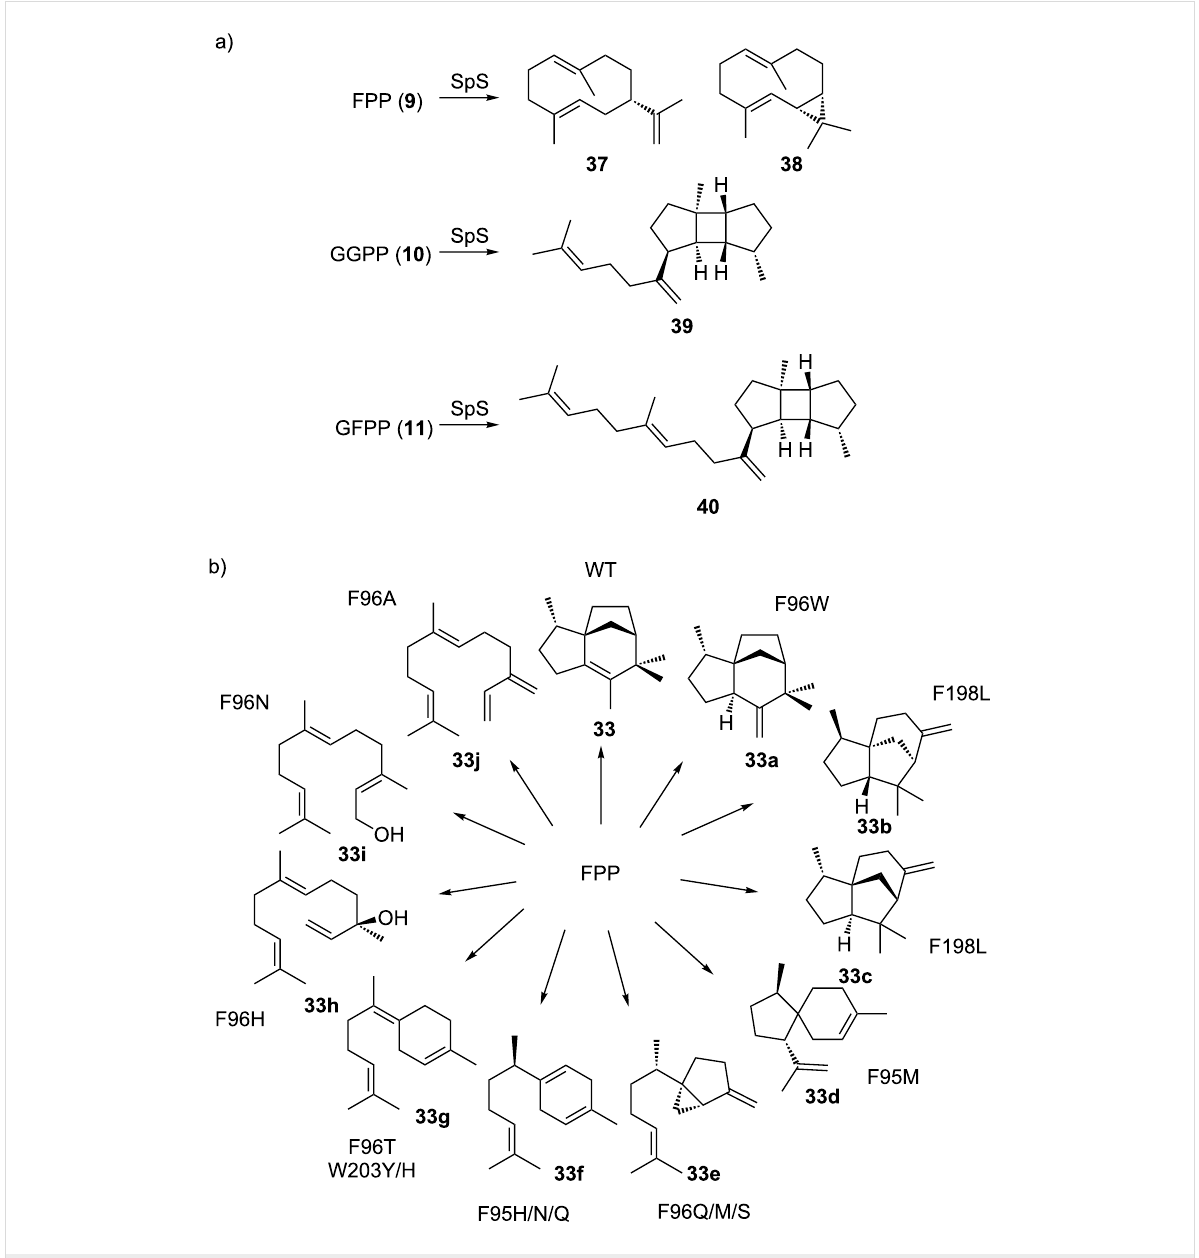
Figure 9: TC promiscuity and engineering. a) Spata-13,17-diene ( 39 ) synthase (SpS) can take C 15 and C 25 oligoprenyl diphosphate as substrates in addition to its C 20 natural substrate. b) Selected examples of epi -isozizaene ( 33 ) synthase mutants that produce different sesquiterpene